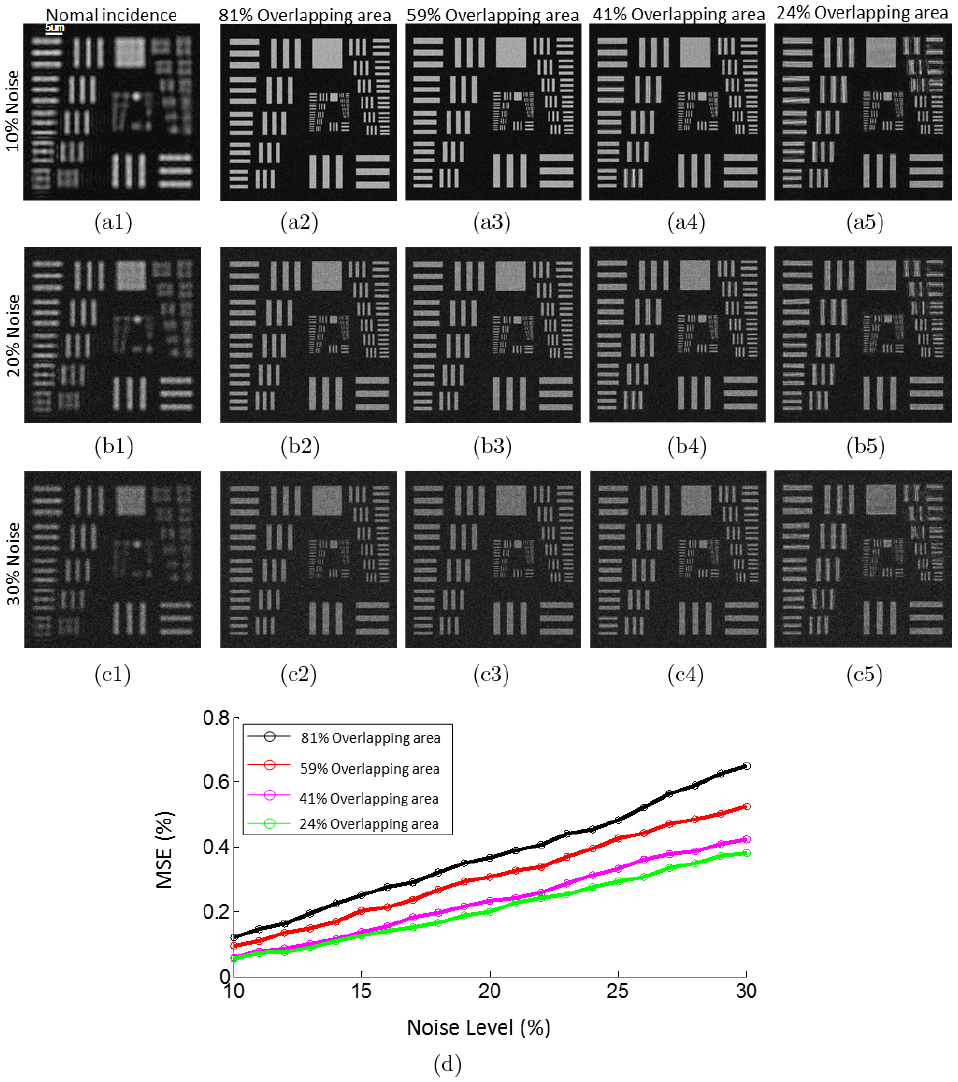
Fig. 8. Simulation results under Gaussian noise with di®erent standard deviations. (a) – (c) Images of resolution target corrupted with 10%, 20%, and 30% Gaussian noise levels, respectively. (a1) – (c1) Low-resolution images acquired under normal illumination. (a2) – (a5), (b2) – (b5), and (c2) – (c5) Images with corresponding Gaussian noises reconstructed by FPM until converges with 81%, 59%, 41%, and 24% overlapping area, respectively. (d) The MSE is described as a function of distinct Gaussian noise levels. Di®erent color lines are corresponding to di®erent overlapping areas in frequency